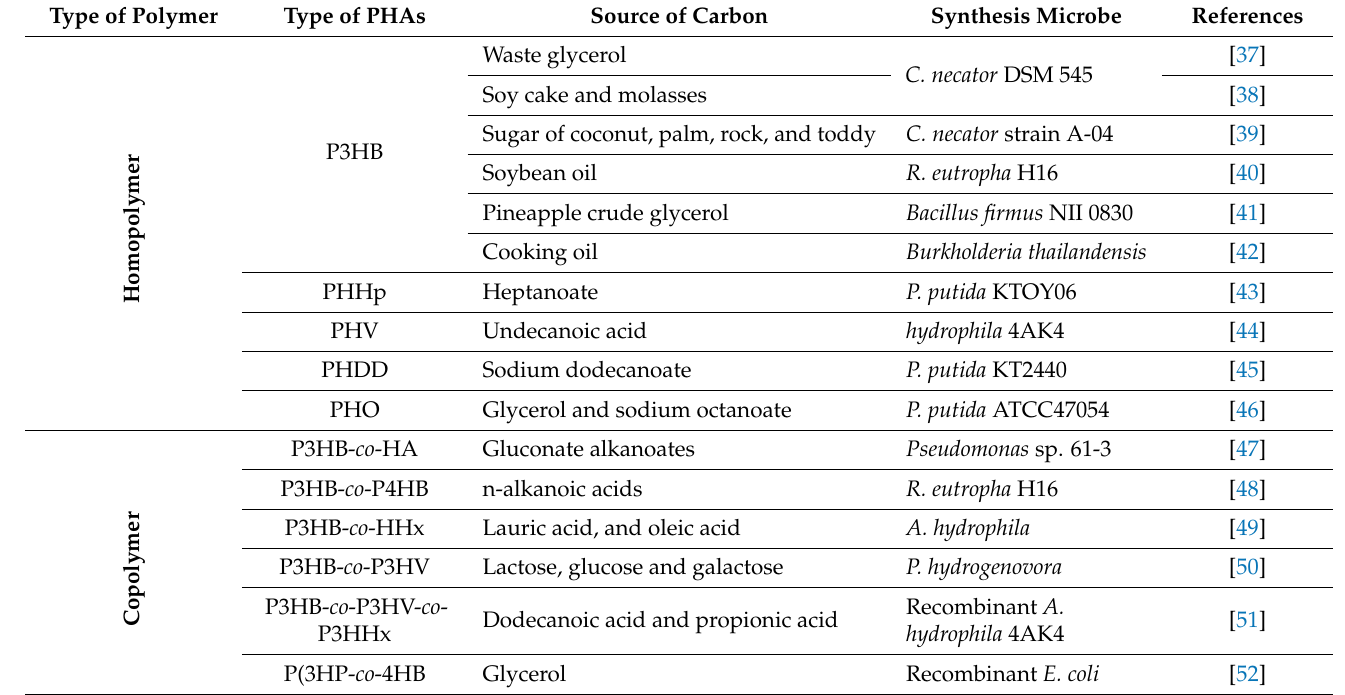
Table 1. Some examples of